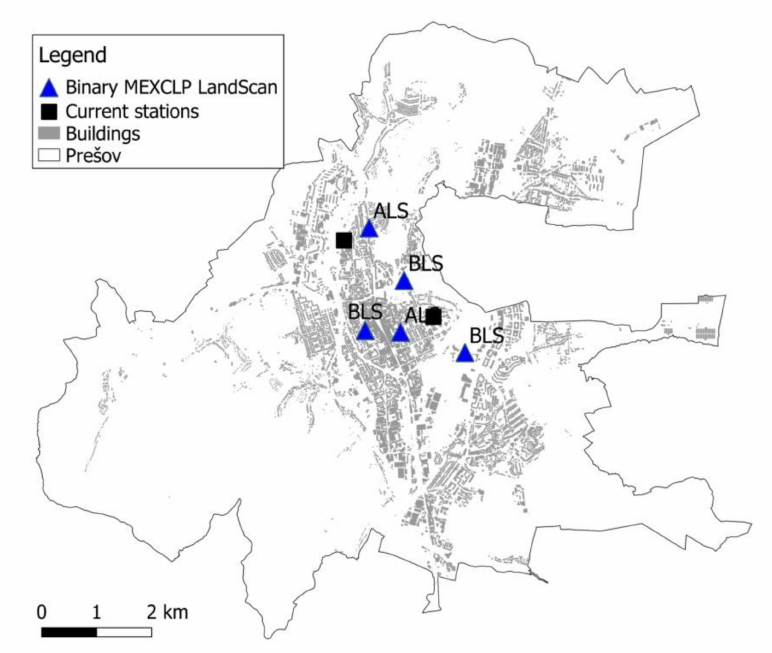
Figure 6. Ambulance locations using the binary MEXCLP model with the LandScan demand